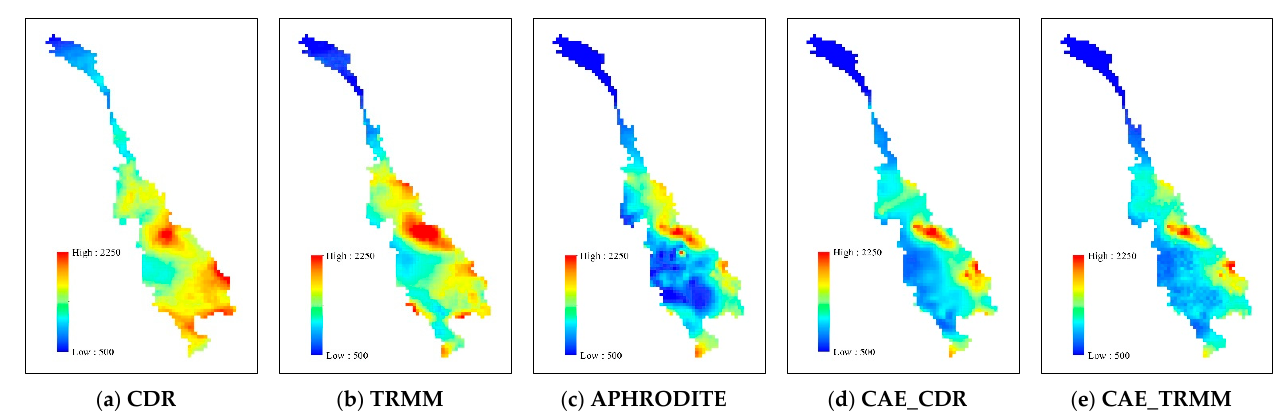
Figure 6. Spatial rainfall distribution of products over the MRB in 2015. Table 3. Quantitative assessment of annual precipitation spatial correlation of products.